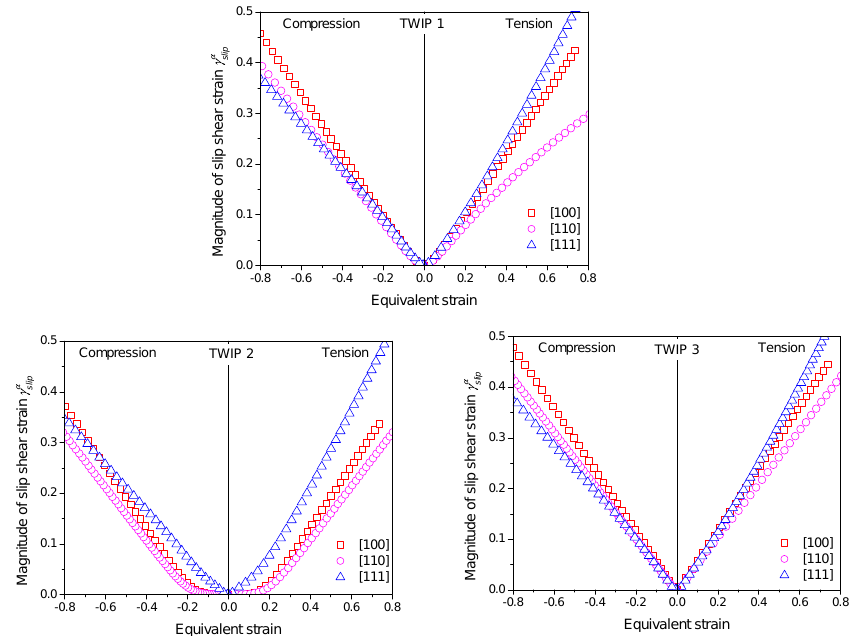
Figure 10. Magnitude of commulative slip shear strain of a single crystal of TWIP steels subjected to tension and compression.